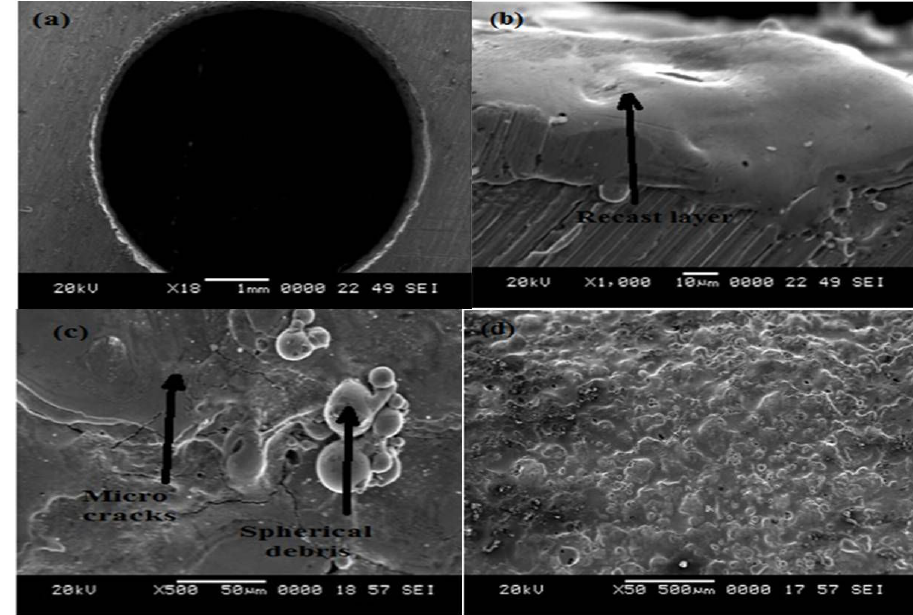
Figure 11: SEM micrograph: Exp No. 15 at T on = 30 µ s; T off = 50 µ s; I p = 2A